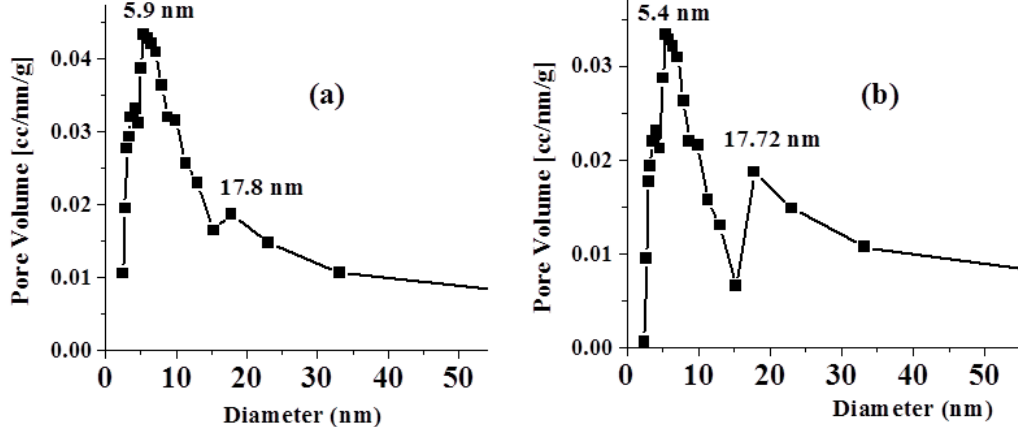
Figure 3. X-ray diffraction pattern of the fresh adsorbent.